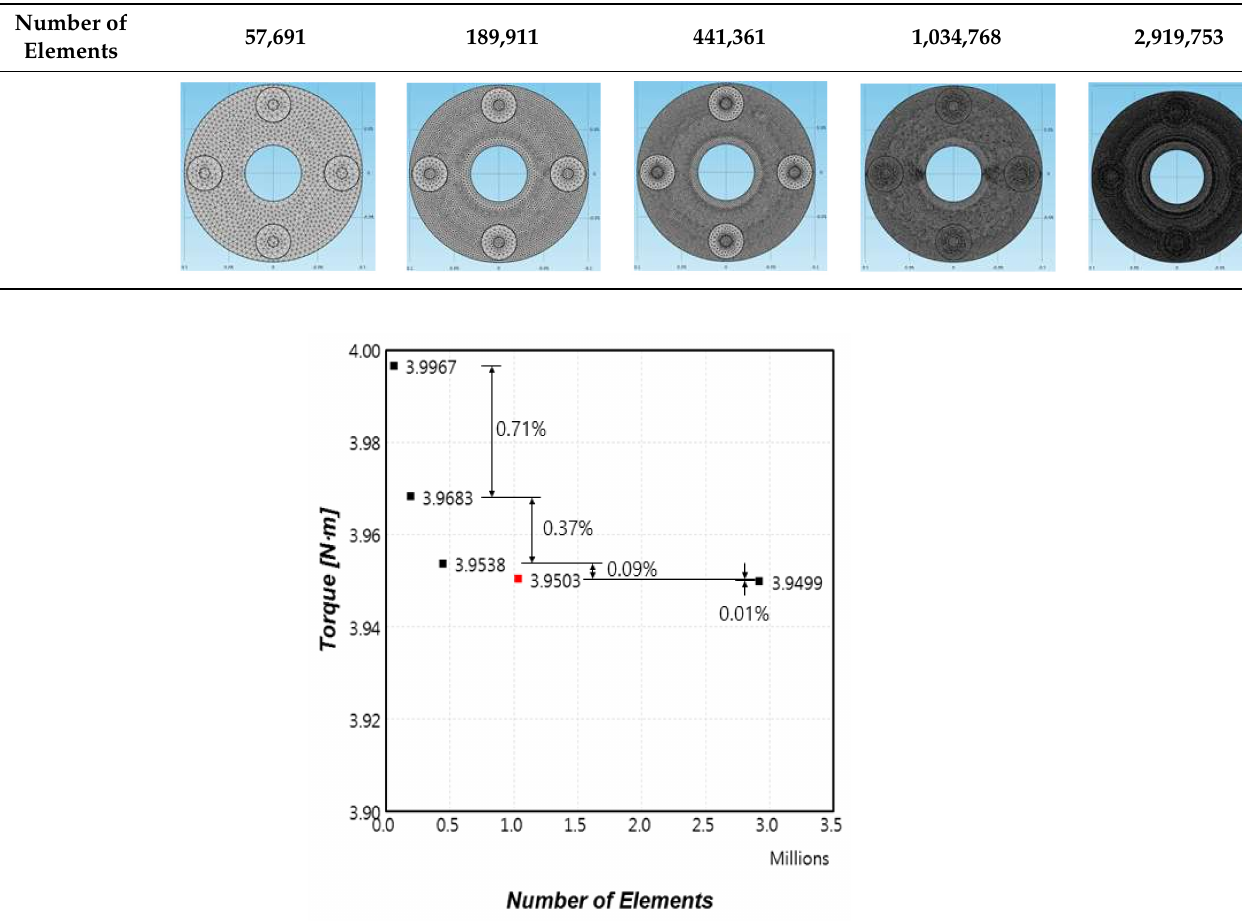
Table 1. Number of elements and domains formed by mesh.